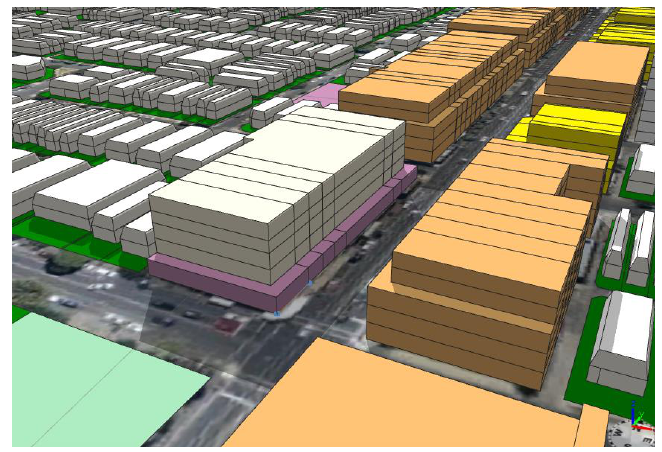
Figure 9. Test of planning zones along the vertical axis (Shadowing time set at 2:00 p.m. in August). The commercial zone is seen in purple on the ground floor.